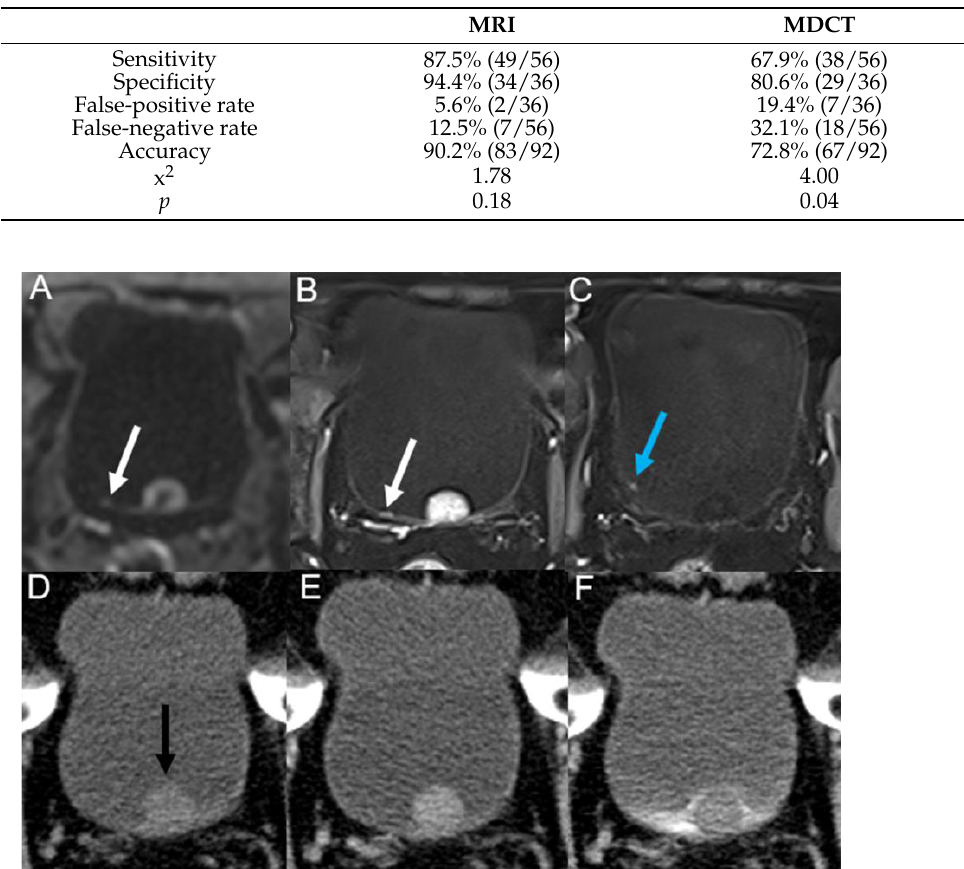
Figure 4. An 86-year-old man underwent trans-urethral resection of BC 48 months ago. T2WI ( A ), DWI ( B ), apparent diffusion coefficient ( C ) and DCE ( D ) images show a papillary mass (arrow) with a diameter of 0.9 cm in the left posterior wall of the bladder. However, multidetector computed tomography (only nephrographic ( E ) and bladder filling ( F ) phases are shown in the figure) shows no definitely noticeable lesion. Postoperative pathology confirmed non-muscle-invasive low-grade papillary urothelial carcinoma. One case of obvious diffuse wall thickening and one case of irregular wall thickening with patchy protrusion into the bladder were misdiagnosed as BCs by MRI and MDCT,